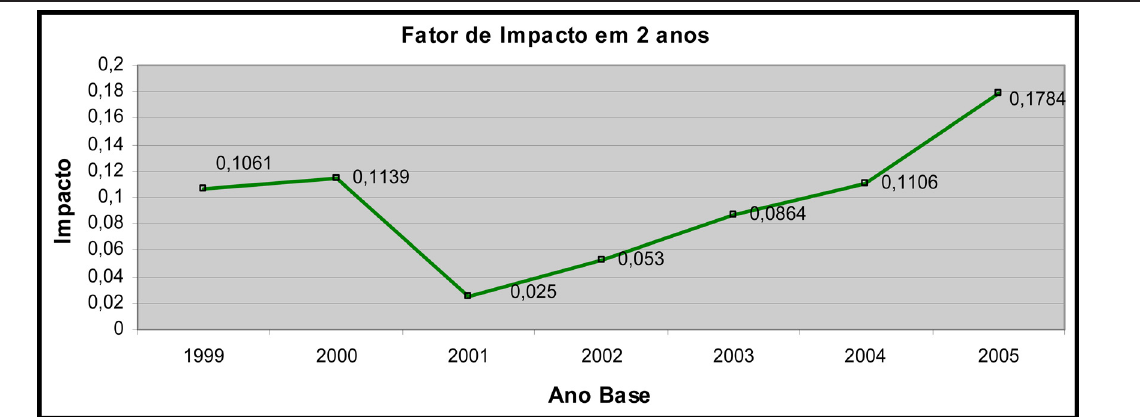
FIGURA 8 - Exemplo do indicador de vida média da Acta Cirúrgica para o ano de 2004